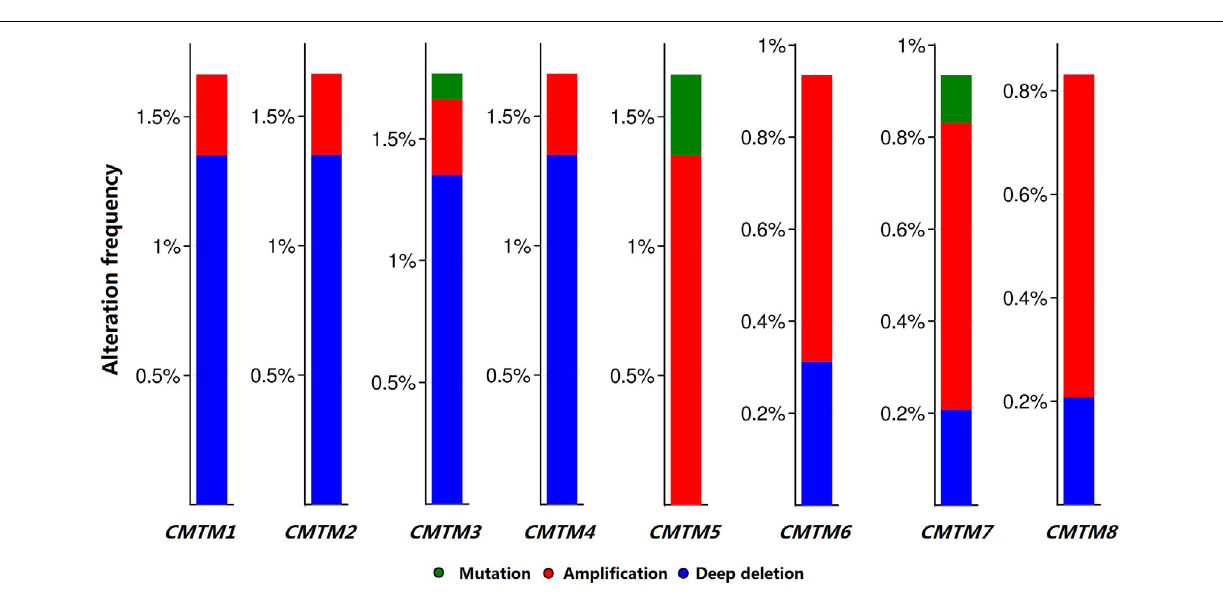
FIGURE 3 | Genetic alteration frequency data of CMTM family members in breast cancer using